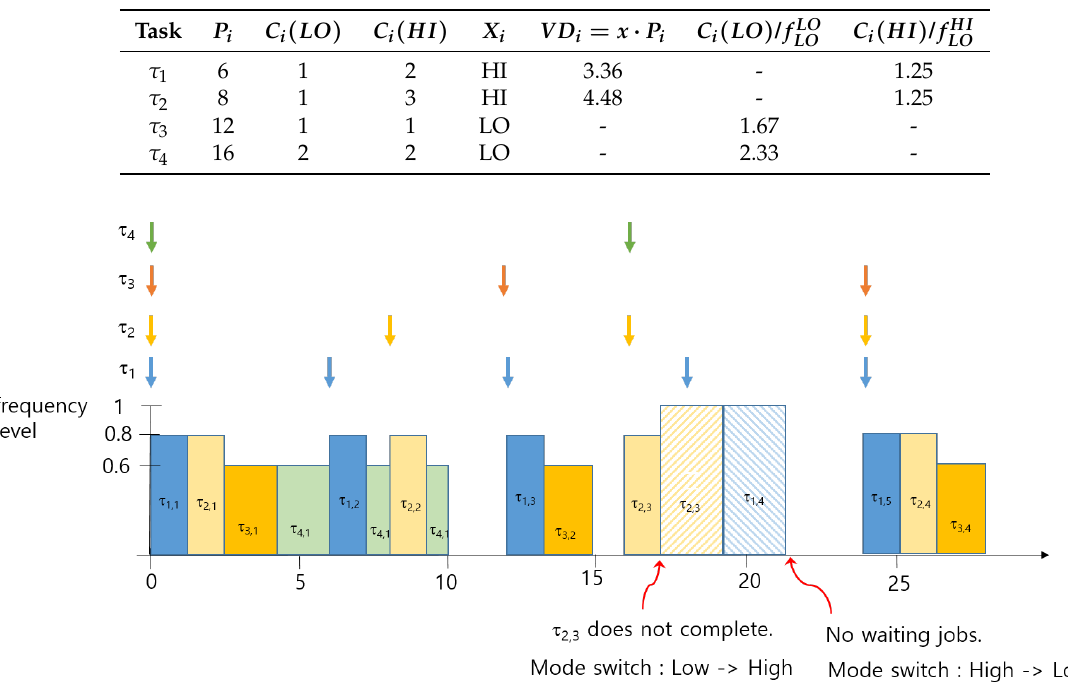
Table 1. An example of tasks.